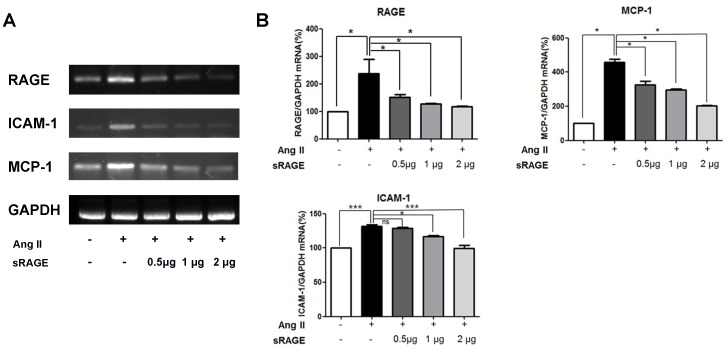
Effects of sRAGE on mRNA Levels in Aorta of AngII-induced Apo E KO mice.A. Reverse transcription PCR analysis of RAGE, ICAM-1 and MCP-1 gene expression. Data in histograms represent mean ± SD from 3 experiments. Lane 1, saline injection; lane 2, infusion of AngII; lane 3, infusion of AngII with 0.5 µg/day of sRAGE; lane 4, infusion of AngII with 1 µg/day of sRAGE; lane 5, infusion of AngII with 2 µg/day of sRAGE. B. RAGE, ICAM-1 and MCP-1 mRNA expression level were determined by Real-Time PCR. Results are means ± SD from 3 experiments each performed in duplicate. *p<0.05, **p<0.01, *** p<0.001 and ns = non-significant.